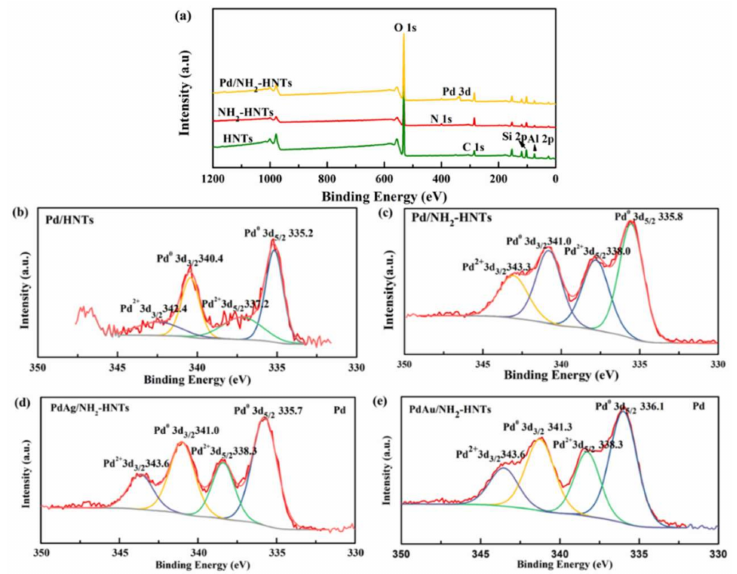
Figure 4. XPS spectra. ( a ) Full spectra of HNTs, NH 2 -HNTs and Pd/NH 2 -HNTs; ( b ) Pd spectra of Pd/HNTs; ( c ) Pd spectra of Pd/NH 2 -HNTs; ( d ) Pd spectra of PdAg/NH 2 -HNTs; ( e ) PdAu spectra of Pd/NH 2 -HNTs.